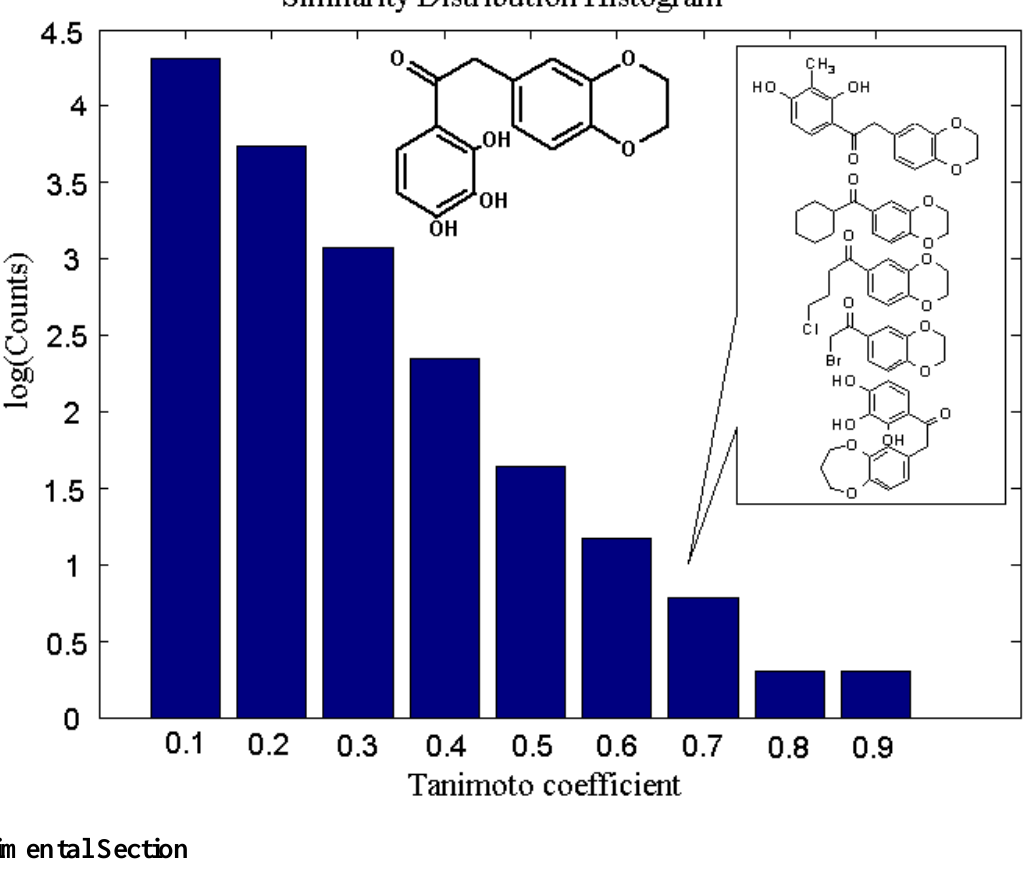
Figure 5. The histogram representing the similarity score distribution for the entire subset of molecules in the Ligand database calculated for the chosen search structure. The substructure bias, assessing the level of molecular similarity, is accomplished by setting the similarity measure ranging from 0.1 to 1.0. The examples of molecules with Tanimoto coefficient ≥ 0.7 are given in the internal